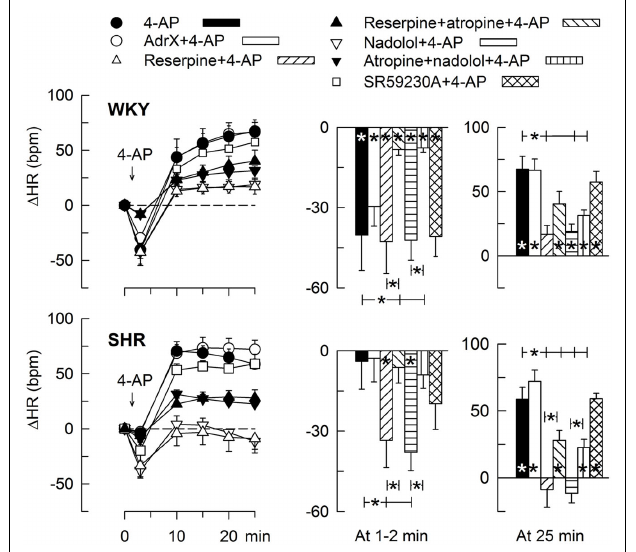
FIGURE 5 | HR-response to 4-AP after removal of components of the adrenergic system. The rats were pre-treated to eliminate adrenal (AdrX) or neuronal (reserpine) catecholamines, peripheral β 1 + 2 AR (peripherally restricted antagonist nadolol), or β 3 AR-activity ( β 3 AR antagonist SR59230A). Reserpine and nadolol were also combined with mAChR antagonist (atropine), as indicated by symbol legends. Column graphs to the right shows HR nadir during the initial response (1–2min) and Δ HR at 25min. Significant responses (* within column) and group differences (brackets) were located as indicated. Baseline HR was slightly reduced after reserpine and nadolol inWKY and clearly after nadolol in SHR ( Table 2 ). * – P ≤ 0.025.